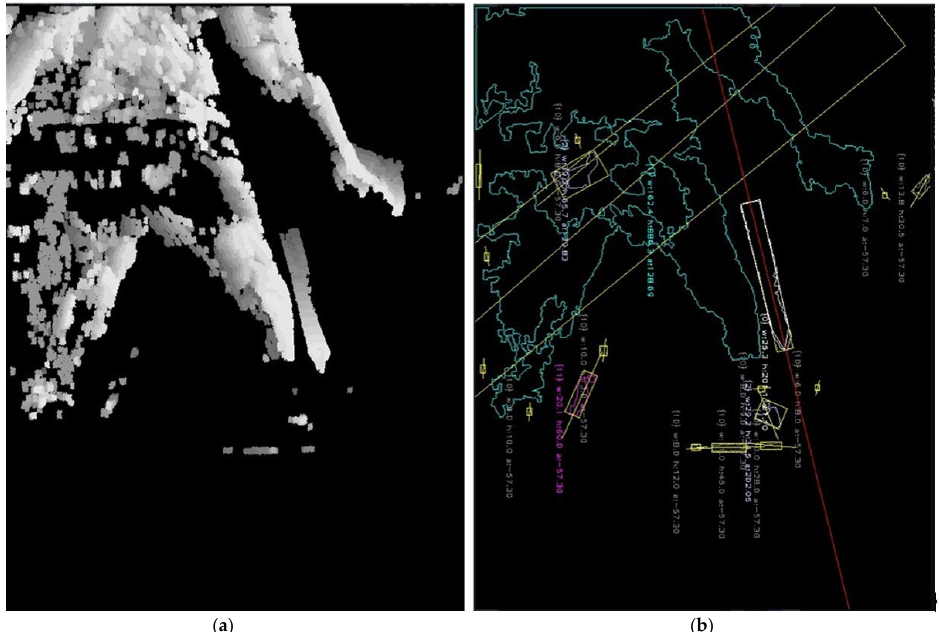
Figure 7. Accumulative differential frame ( a ) (on the left ). Blobs with marked moving direction by lines ( b ) (on the right ). The white blob is the one that was marked as a shuttlecock. The color of a blob represents the filter that filtered out the shuttlecock candidate.